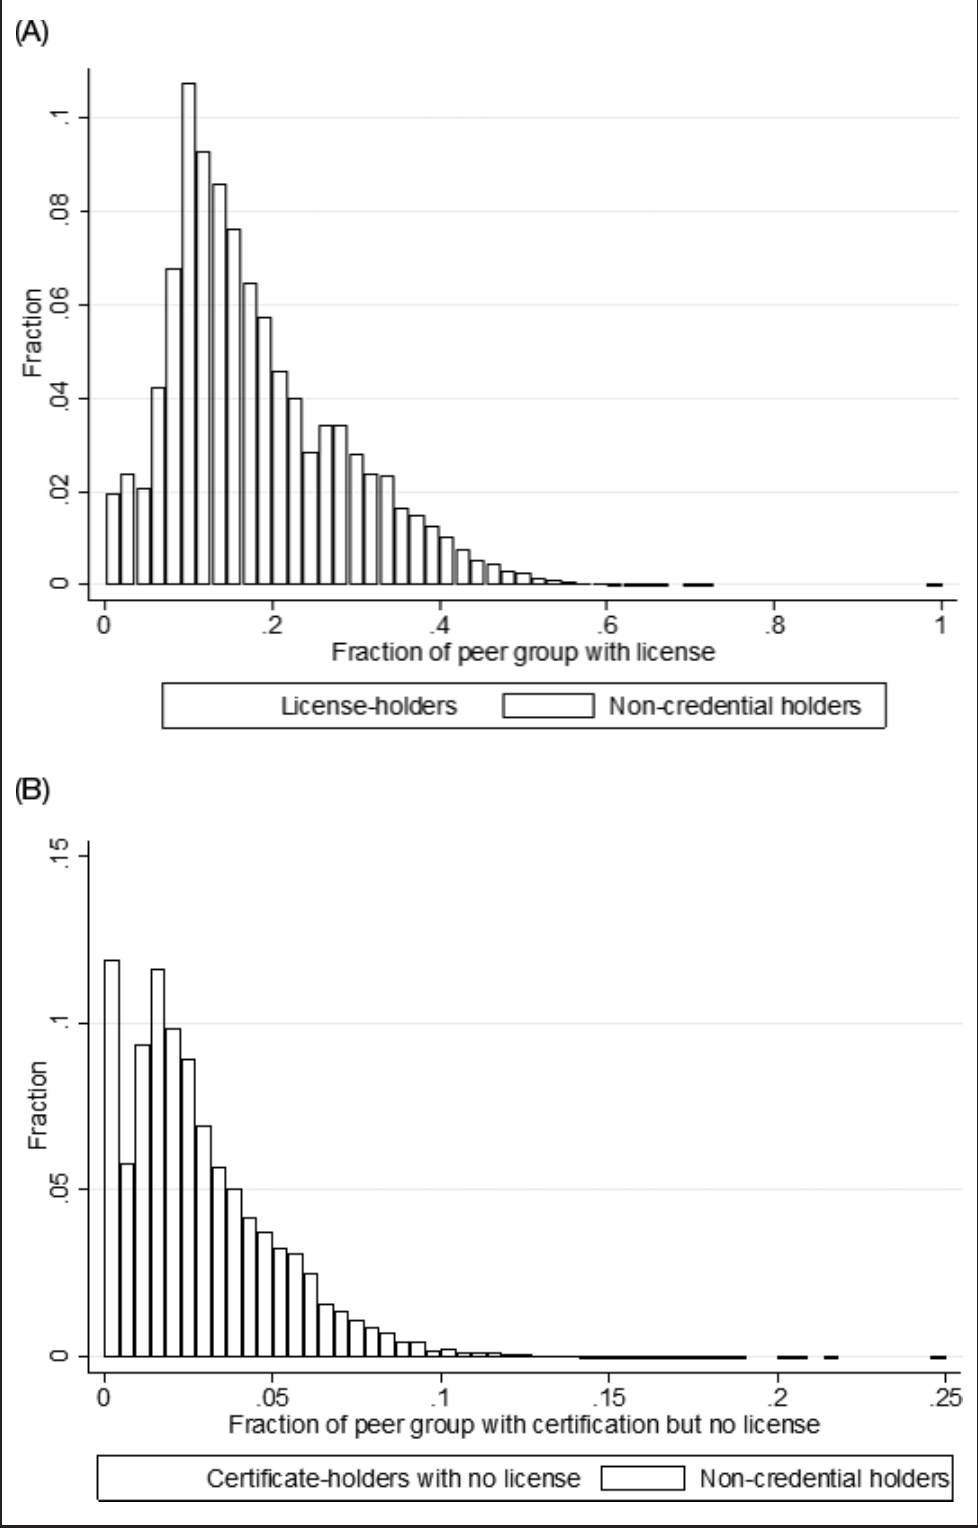
Figure A1 Marginal treatment effects of occupational credential-holding for log wages, conditional on being employed. (A) Licenses and (B)